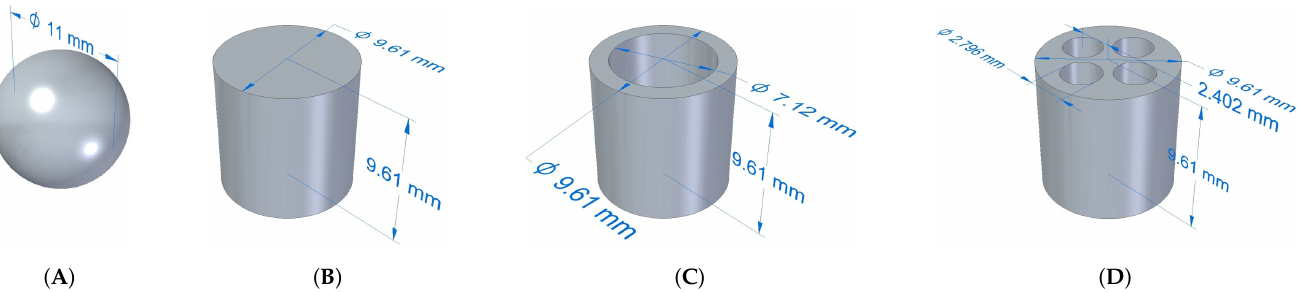
Figure 2. Investigated particle shapes: ( A ) spheres, ( B ) cylinders, ( C ) rings, and ( D ) 4-hole